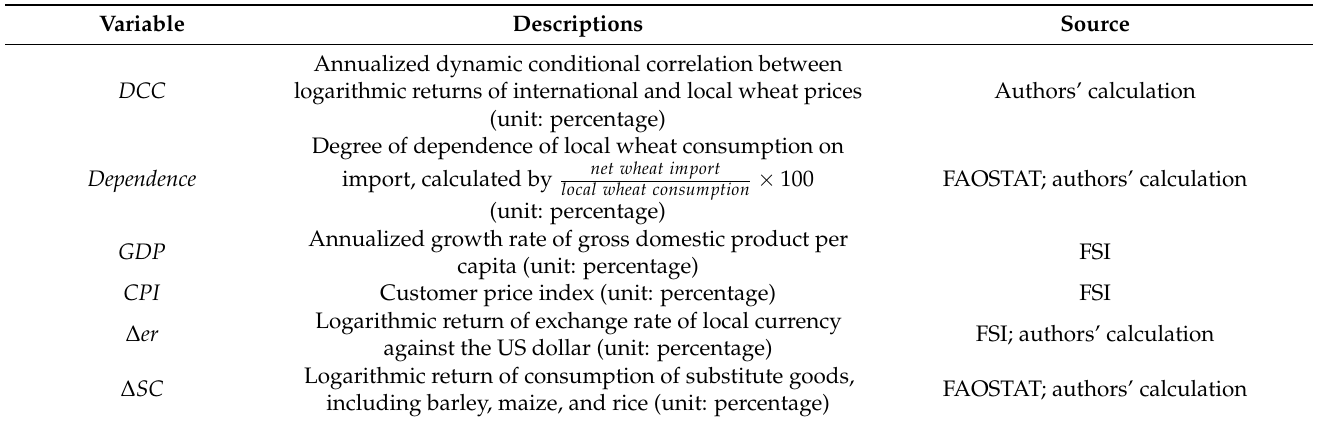
Table 2. Panel analysis variable descriptions.